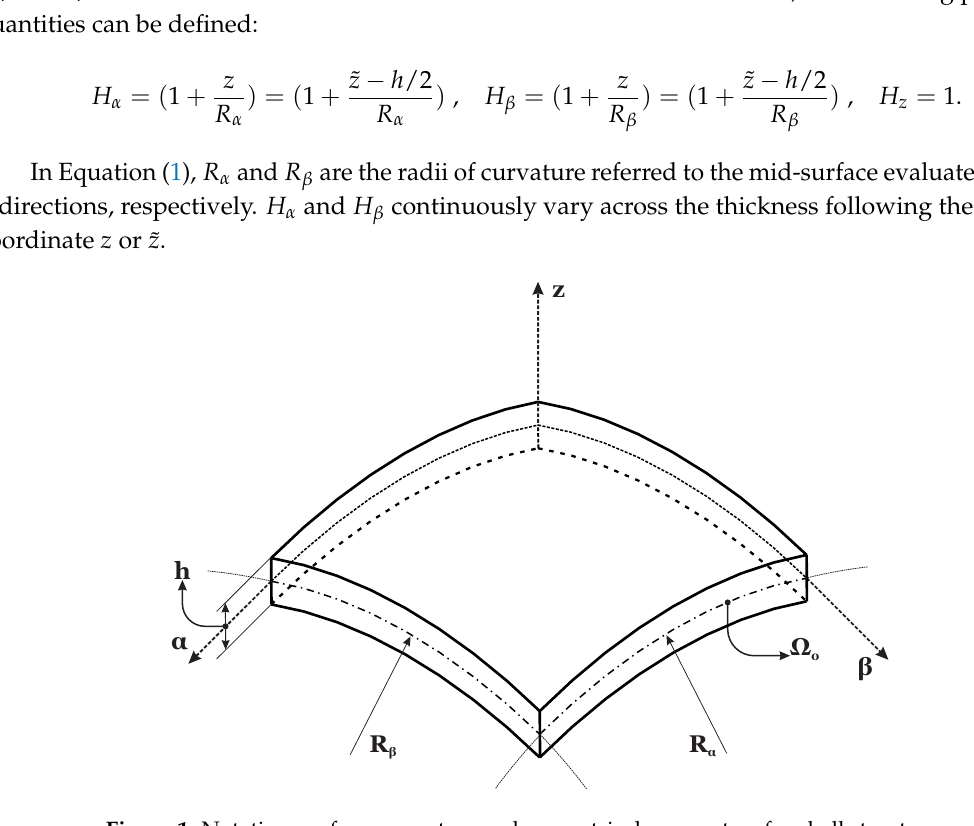
Figure 1. Notations, reference system and geometrical parameters for shell